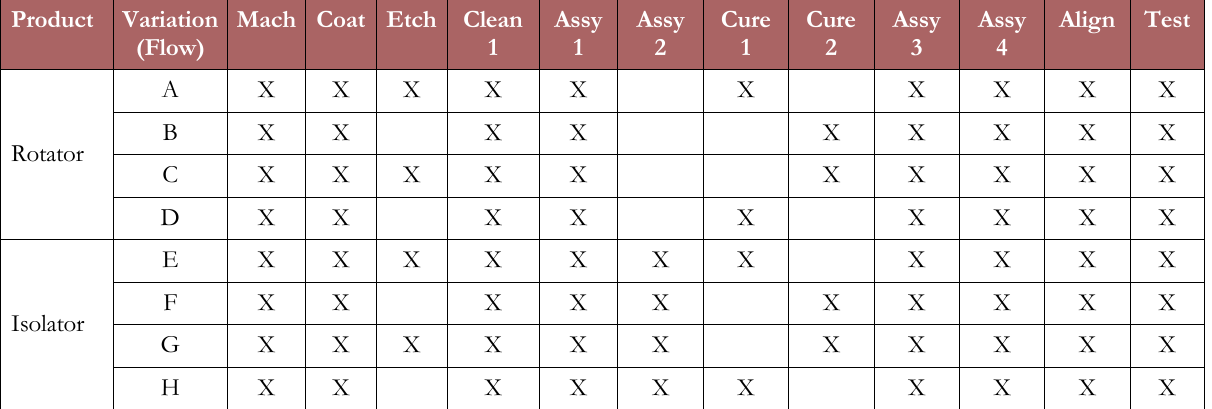
Table 1. Product Variations with Corresponding Process